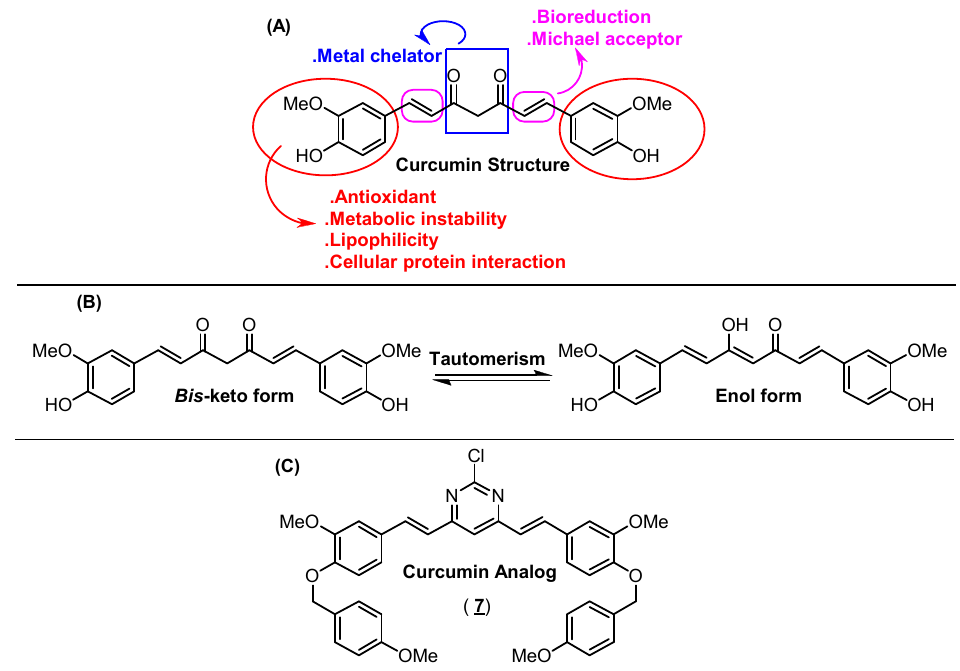
Figure 1. ( A ) Chemical structure of curcumin and its simplified structural-activity relationship. ( B ) Tautomerism form for curcumin. ( C ) Chemical structure for the curcumin analog under study— compound 7 .